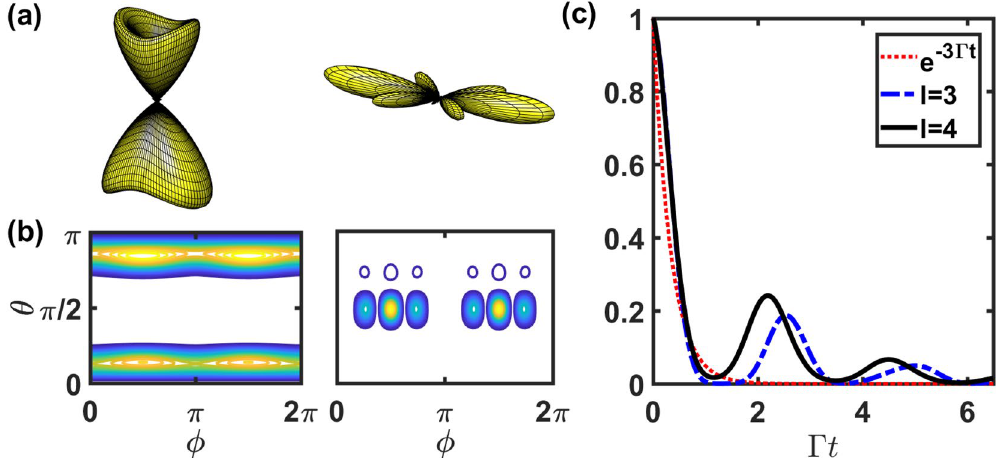
Figure 6. The far-field Ω f ( θ , φ ) of ˆ x -polarized HPI three-photon states for N φ = 8 and N z = 2 in the stacked rings. The subradiant states with ( a ) l = 3 and l = 4 are illustrated from left to right with corresponding two- dimensional plots in ( b ). ( c ) The fluorescence intensity I 0 (t) of the HPI three-photon states compares with e − 3 Γ t (dot). The viewing angle and other parameters are the same as in Fig.